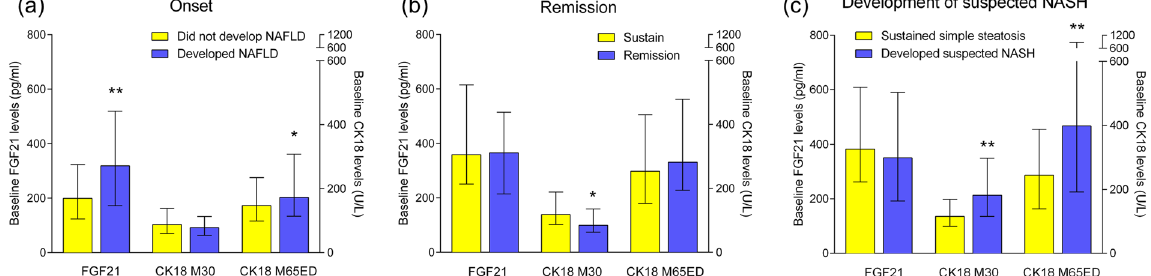
Figure 1. Comparison of FGF21, M30 and M65ED levels at baseline in different groups. ( a ) Baseline FGF21, M30, M65ED levels in subjects who developed simple steatosis (n = 70) and who did not (n = 363). ( b ) Baseline FGF21, M30, M65ED levels in subjects who sustained NAFLD (n = 93) and who had remission during follow-up (n = 30). ( c ) Baseline FGF21, M30 and M65ED levels in subjects who sustained simple steatosis (n = 69) and subjects who developed suspected NASH (n = 24). Data represent median (interquartile range). * P < 0.05, ** P < 0.01, *** P < 0.001.